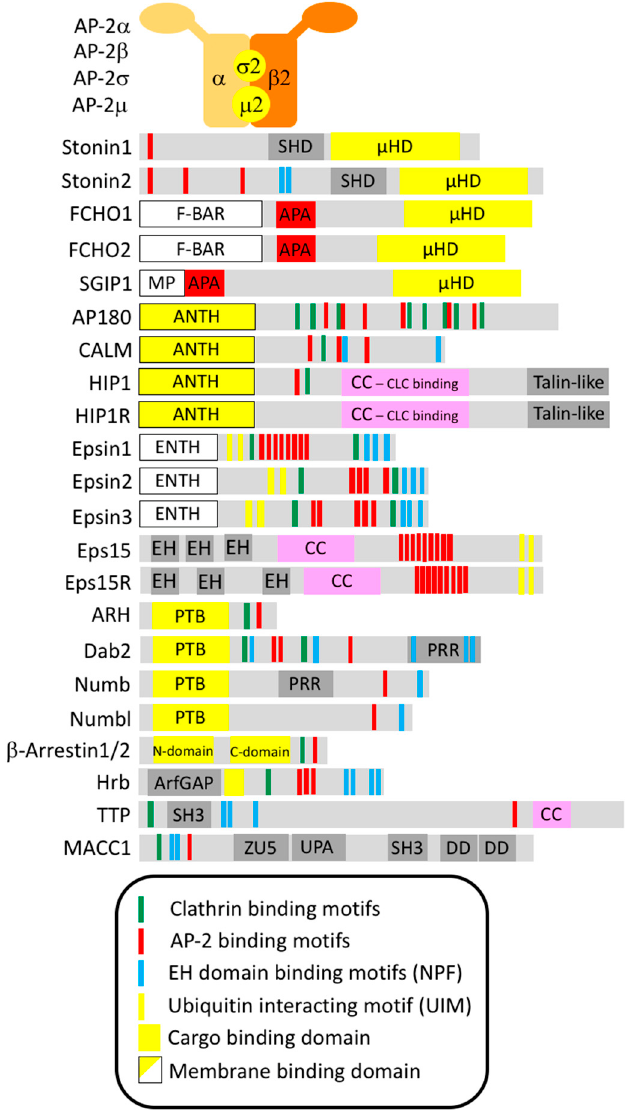
Figure 2. Domain structure of the known and proposed endocytic adaptors. Sketch of the domain structure of endocytic adaptor proteins including putative endocytic binding motifs. Domain structures were based on the following references: AP-2 [8], Stonin1 / 2 [25], FCHO1 / 2 and SGIP1 [26], AP180 and CALM [27], HIP1 and HIP1R [28], Epsin1 / 2 / 3 [29], Eps15 and Eps15R [30], ARH [31], Dab2 [32], Numb and Numbl [33], β -Arrestin1 / 2 [34], Hrb [35], TTP [36], MACC1